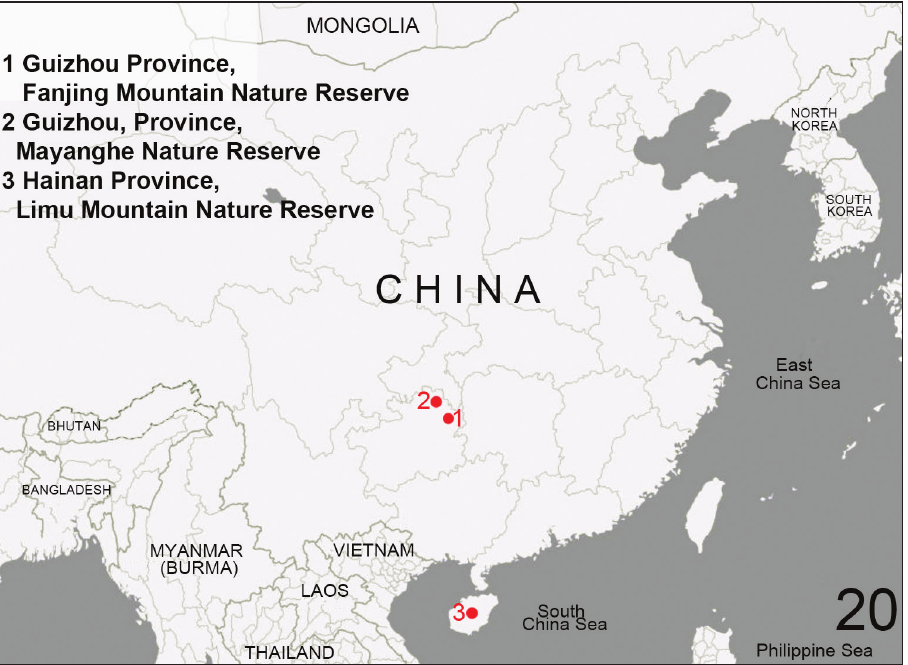
Figure 20. Distribution of Clubiona grucollaris sp. n. (red